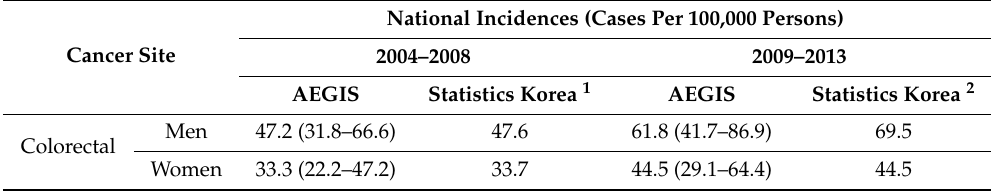
Figure 3. Disease mapping for regional di ff erences in the incidence of liver cancer (women) in South Korea and the United States from 2009 to 2013 (age adjusted). Table 3. Comparison of the estimated major cancer incidences (age adjusted) from AEGIS with the findings of relevant published